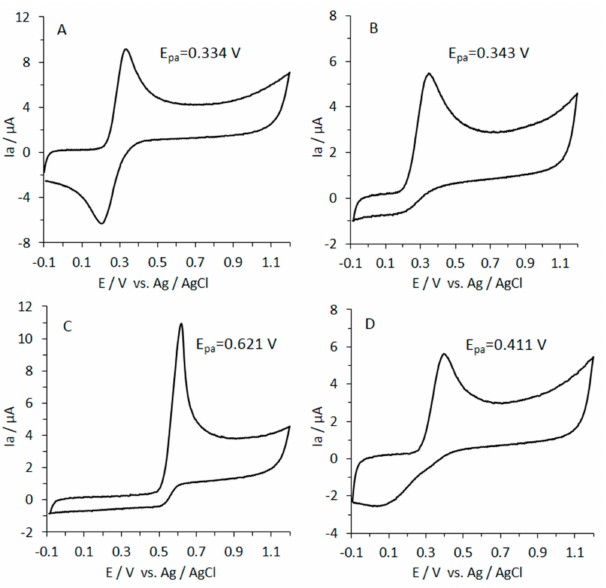
Figure 6. Cyclic voltammograms of 0.25 mM of standards solution (final concentration) of caffeic acid ( A ), L-ascorbic acid ( B ), uric acid ( C ), and Trolox ( D ) in 0.1 Britton–Robinson (B–R) buffer (pH 6.0) recorded from − 100 to +1200 mV; scan rate 100 mV s − 1 .